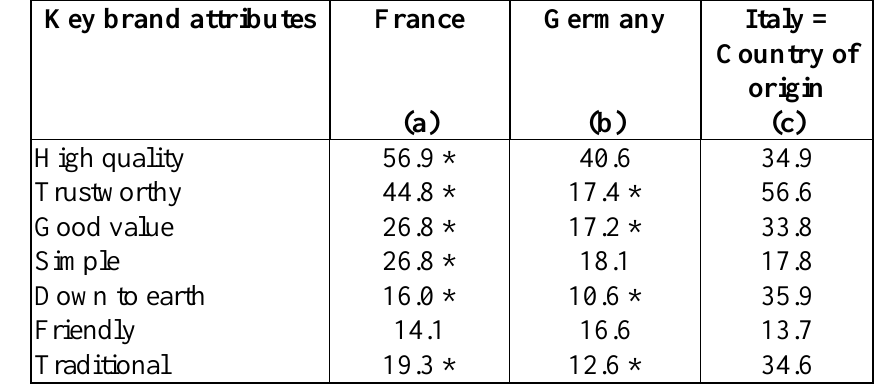
Table 4: Barilla Image Attributes in Country of Origin Versus other Countries Key brand